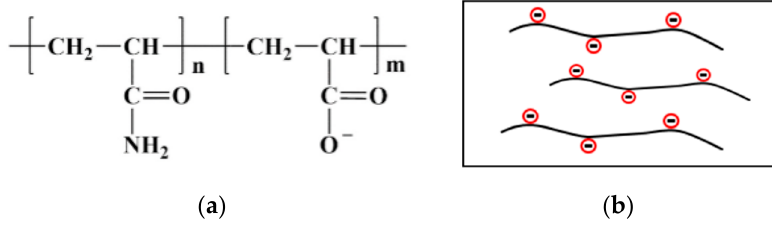
Figure 1. ( a ) The chemical structure [38] ( b ) physical structure of hydrolyzed polyacrylamide (HPAM) polymer.